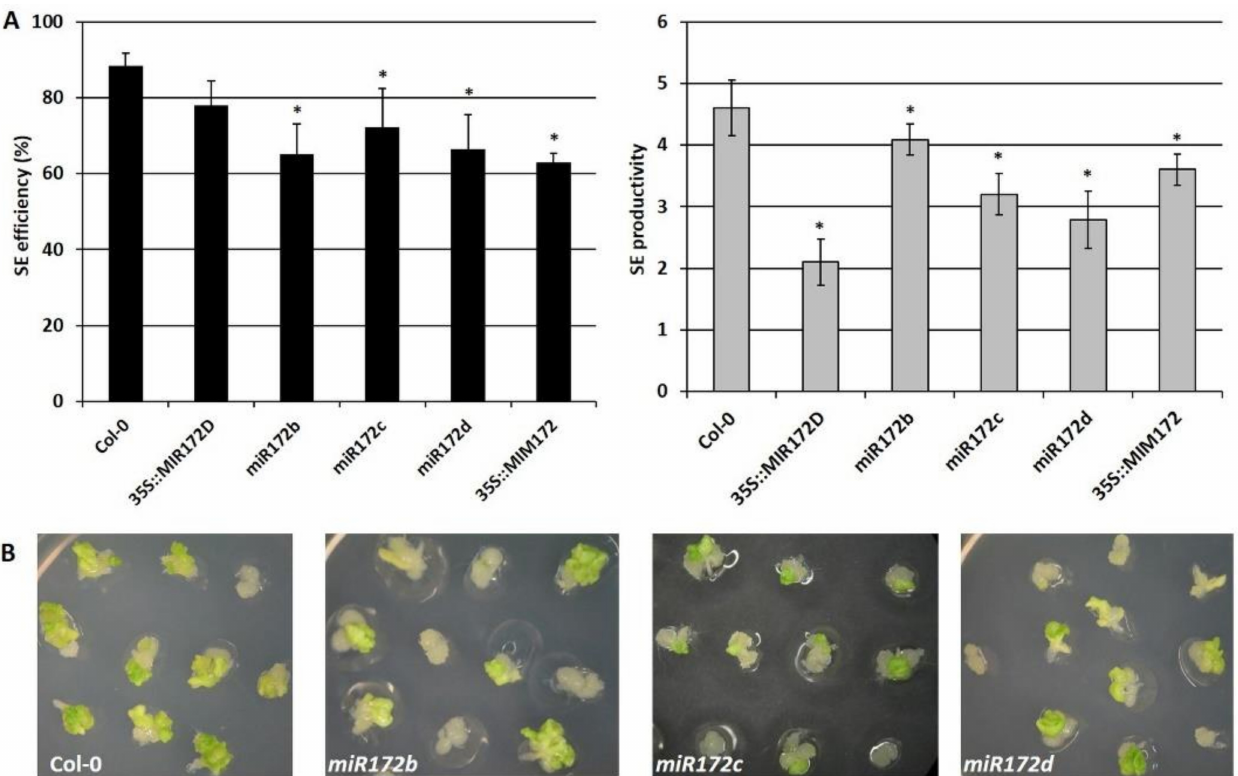
Figure 1. miR172 contributes to the embryogenic potential of a culture. There was a significant decrease in the SE efficiency and SE productivity of the miR172-affected genotypes, including the miR172 mutants ( miR172b, miR172c, miR172d ), the MIR172D -overexpressing line (35S:: MIR172D ) and the MIM line (35S::MIM172) vs. the WT control (Col-0) culture ( A ). There was also a decrease in the embryogenic responses of the miR172b , miR172c , miR172d mutants compared to the Col-0 culture ( B ). The explants were induced on an auxin (E5) medium and the embryogenic response was evaluated in 21-day-old cultures. * values significantly different from the WT, Col-0 ( p < 0.05; n = 3 ±